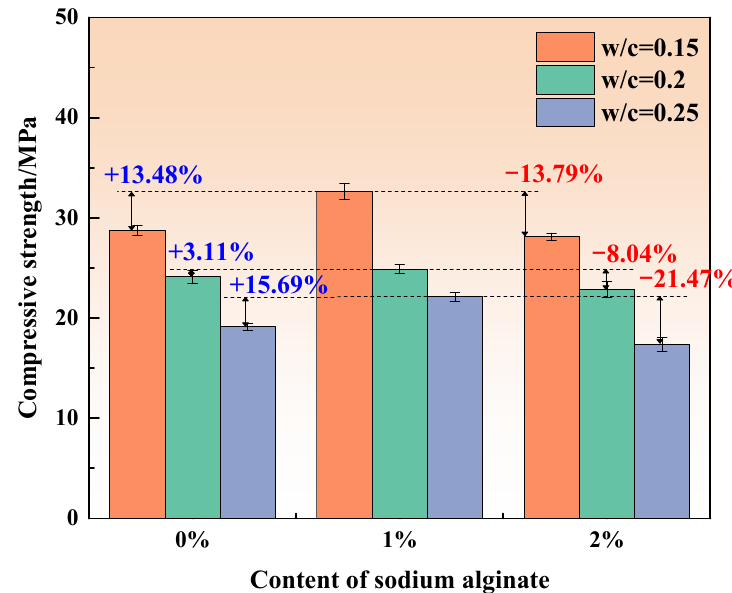
Figure 3. Compressive strength of the MKPCs after 3 h of curing.